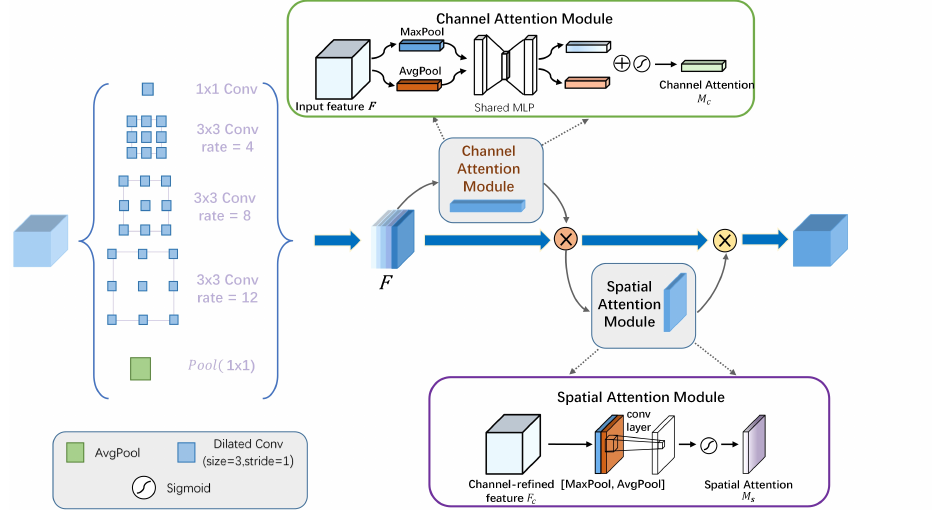
Figure 6. The architecture of Atrous Spatial Pyramid Pooling with